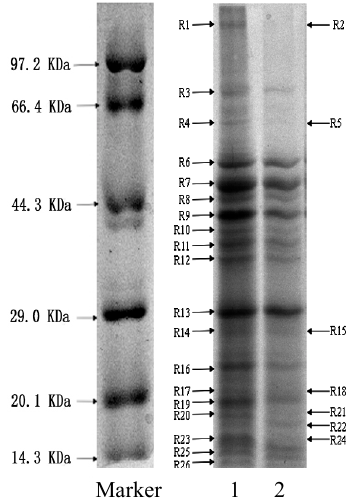
Figure 4. SDS-PAGE of proteins from S. aureus . lane 1, untreated bacteria; lane 2, bacteria treated with the essential oil at 1 × MIC.